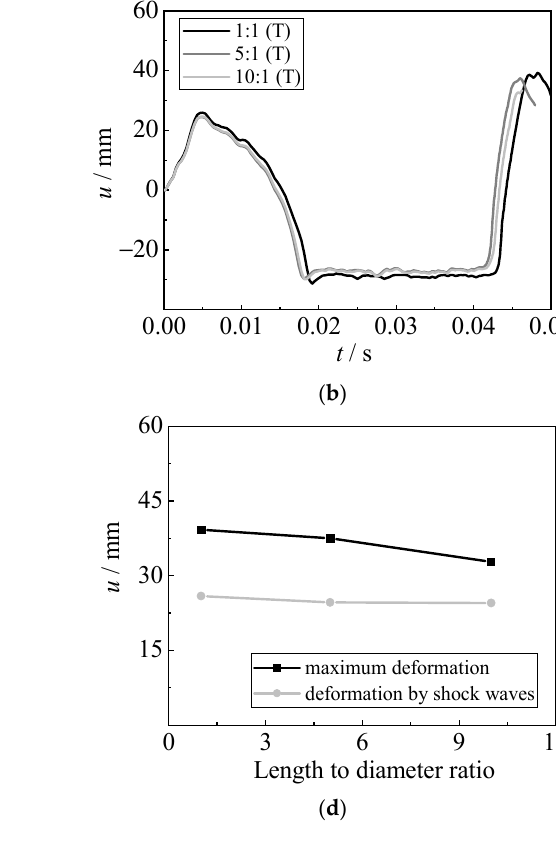
Figure 22. Comparison of the bubble development for various shapes of the charge. 5. Conclusions Three underwater explosion tests with three different TNT charge weights (i.e., 2.5 g, 5 g, and 10 g) were conducted to investigate the dynamic response of a fixed square steel sheet. A FE model was established and benchmarked based on the test results. The deformation development and stress mechanism of underwater explosions have been analyzed experimentally and numerically. Several conclusions can be drawn as follows: